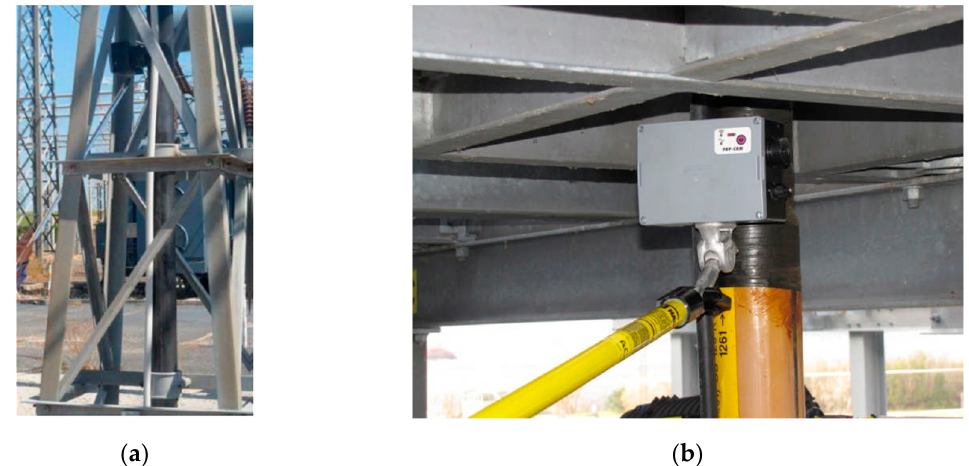
Figure 5. On-site measurements performed by moving the instrument into the proximity of the equipment under testing (EUT) using the hook stick, enabling the operator to be at safe distance. ( These images are extracted from a technical document of Prysmian Electronics s.r.l. ). ( a ) termination earth cable ( b )cable sheath.